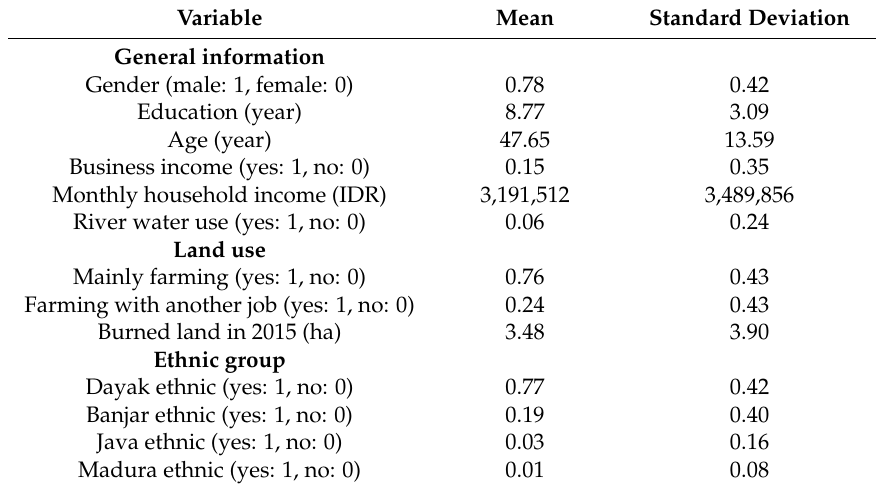
Table 2. Description of sociodemographic variables of landowners with degraded lands in Buntoi village ( n = 150). Means of the dummy variables (1 or 0) represent their percentages in variable categories: male (78%) or female (22%); having business income (15%) or not (85%); farming as main jobs (76%) or additional jobs (24%); using river water (6%) or not (94%); and an ethnicity of Dayak (77%), Banjar (19%), Java (3%), and Madura (1%). Variable Mean Standard Deviation General information Gender (male: 1, female: 0) 0.78